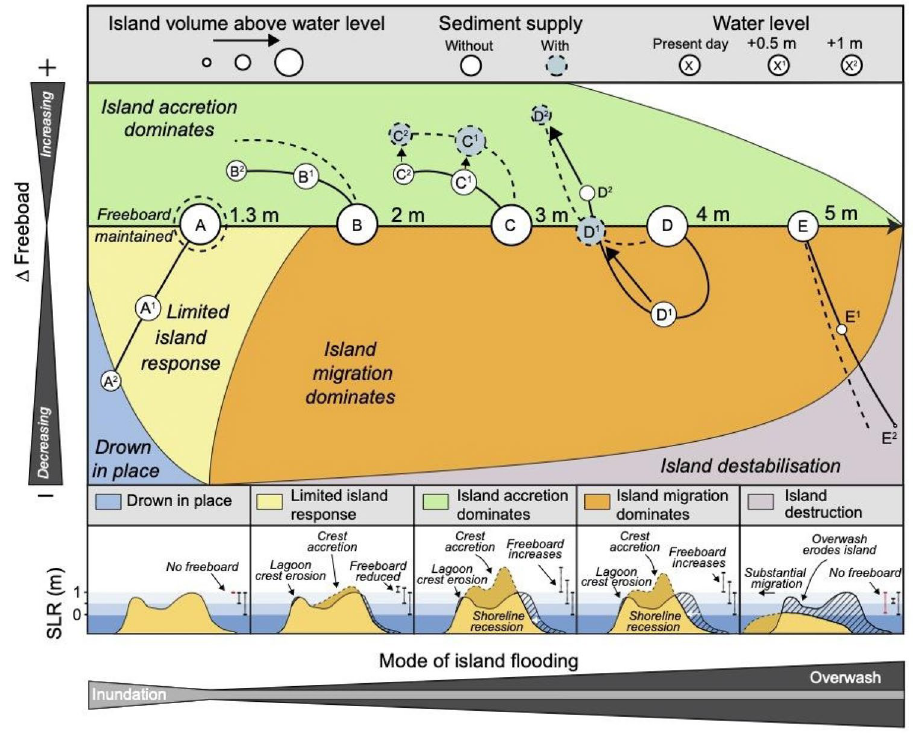
Figure 4. A conceptual model of the geomorphic responses of reef islands to increasing sea level and changing wave conditions with and without a sediment supply. ( A ) Reduced island response and eventual drowning (1.3 m waves), ( B – C ) island building (2–3 m waves), ( D ) island migration (4 m waves), and E) island destruction (5 m waves), observed during physical modelling experiments. The grey and white circles represent results presented during this study and presented in Tuck et al. 21 . Tuck et al. 21 did not simulate sediment supply; therefore, the dashed lines without grey circles depict the conceptually modelled response of island change with a sediment supply. Black arrows show the change in positions of C and D with and without a sediment supply. SS—sediment